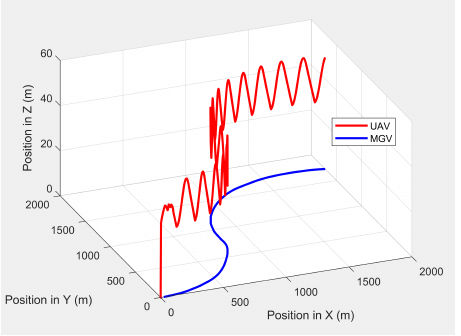
Figure 17. The UAV’s planned path when following the MGV while moving along an unstructured